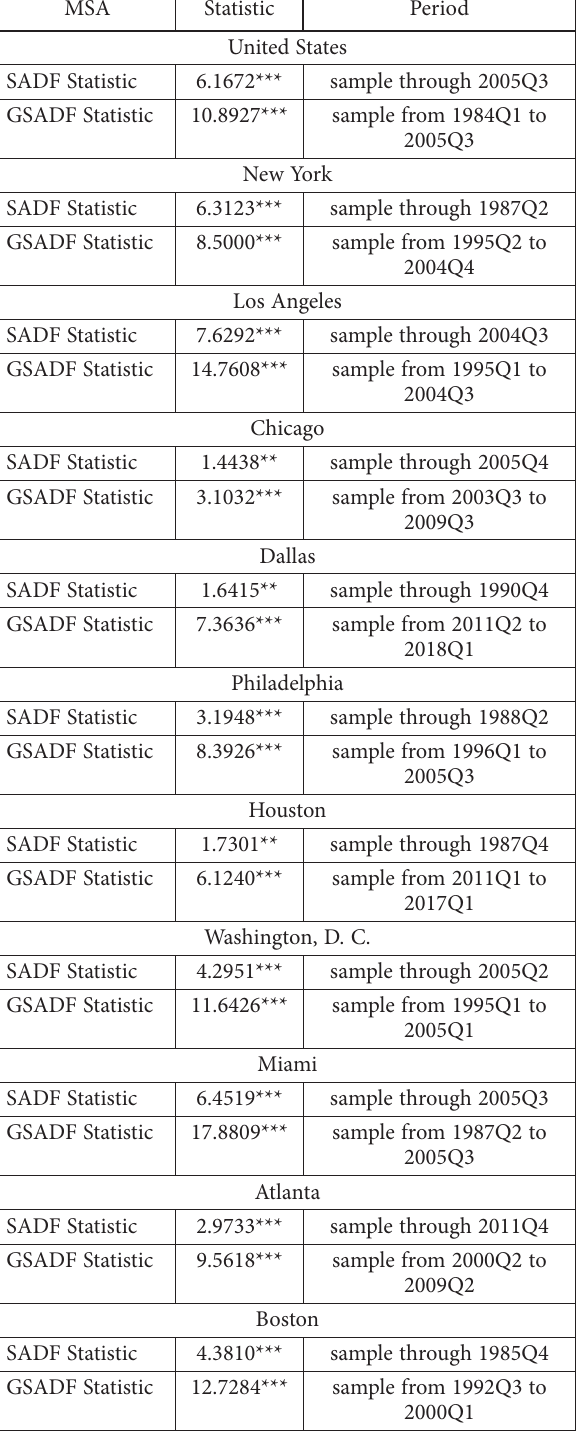
Table 3. Results of SADF and GSADF tests (price-rent